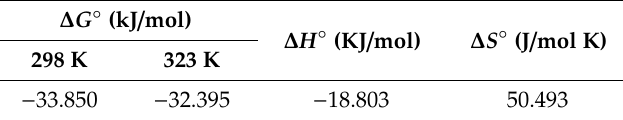
Table 3. Thermodynamic